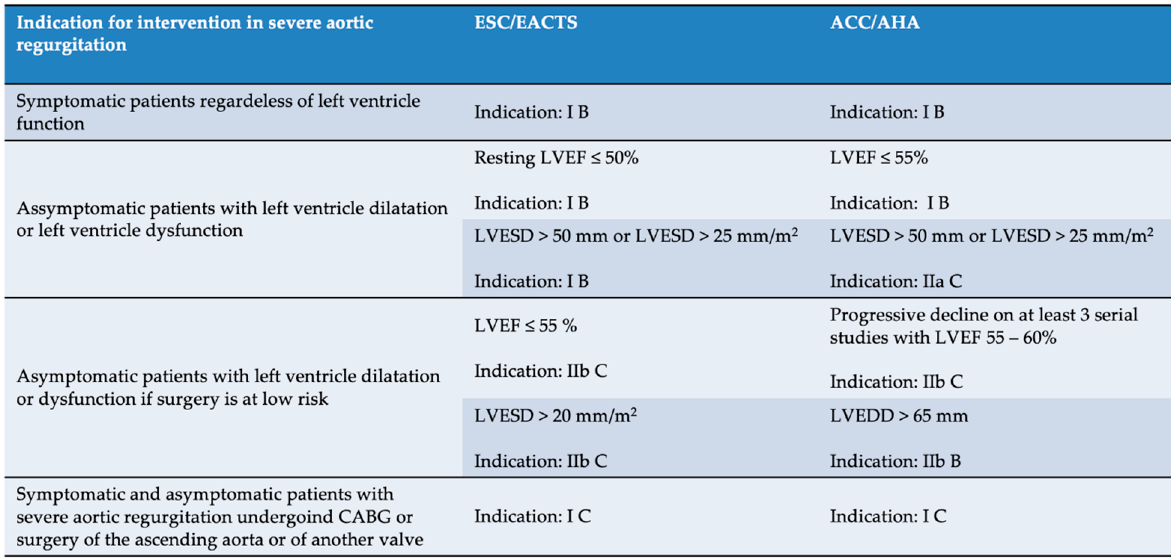
Figure 6. Indications for intervention in significant aortic valve regurgitation according to the Euro- pean (ESC/EACTS—European Society of Cardiology/European Association for Cardio-Thoracic Surgery) and American Guidelines (ACC/AHA—American College of Cardiology/American Heart Association). LVESD—left ventricle end-systolic diameter; LVEF—left ventricle ejection fraction; LVEDD—left ventricle end-diastolic diameter; CABG—coronary artery bypass graft [17,18].